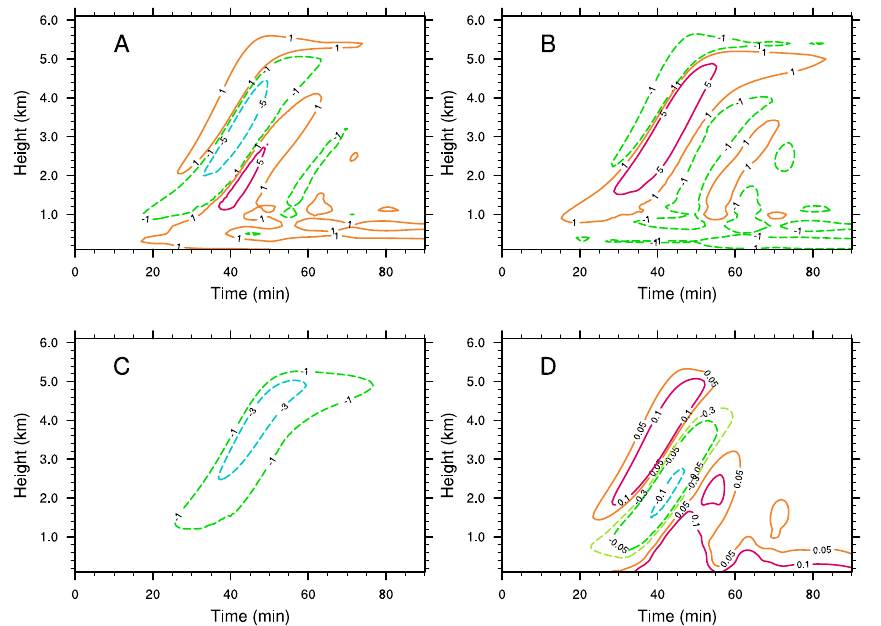
Fig. 2. Spatial and temporal evolution of forces and pressure deviation. (A) Gradient force generated by perturbation pressures per unit mass (cms − 2 ), (B) Thermal buoyancy force per unit mass (cms − 2 ), (C) Drag force per unit mass (cms − 2 ) and (D) Pressure deviation ( mb ) as a function of time and